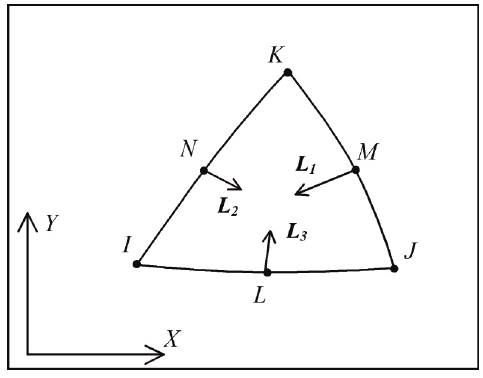
Fig. 3. The geometry of the finite element